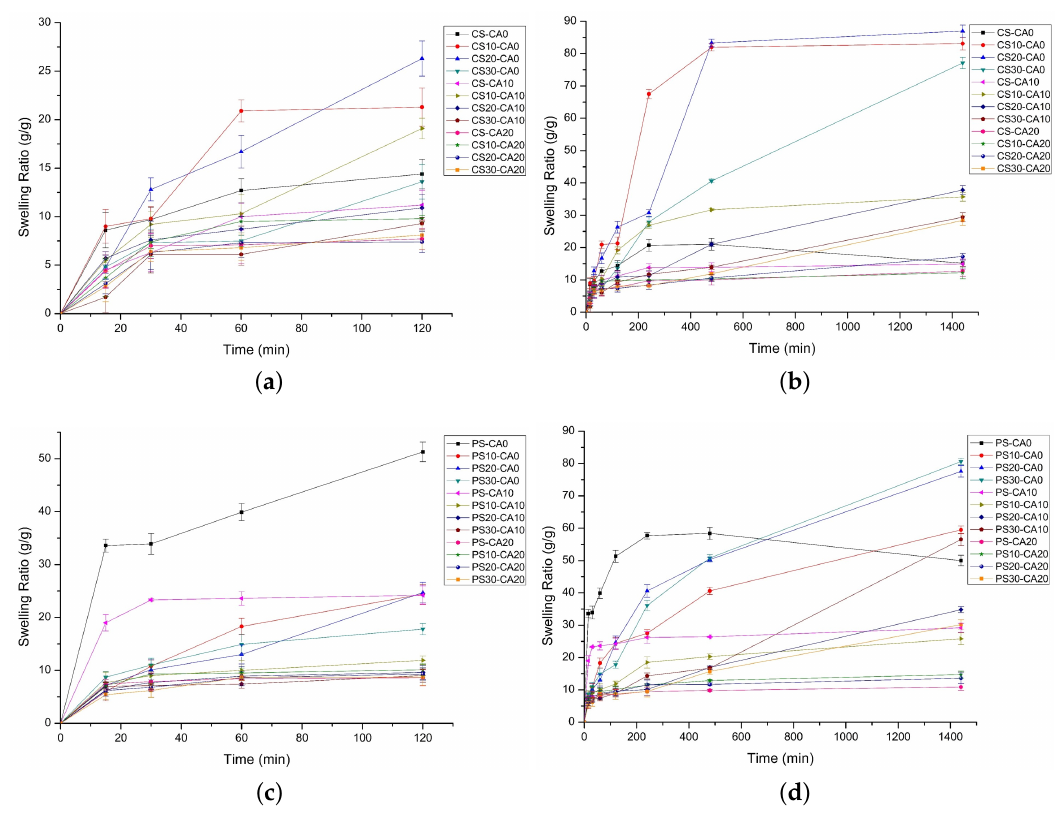
Figure 5. The swelling ratios of polysaccharide-based SAPs using corn starch series ( a , b ) and potato starch series ( c , d ): the initial swelling in 2 h ( a , c ) and the whole swelling in 24 h ( b , d ) (mean ± SD, n =